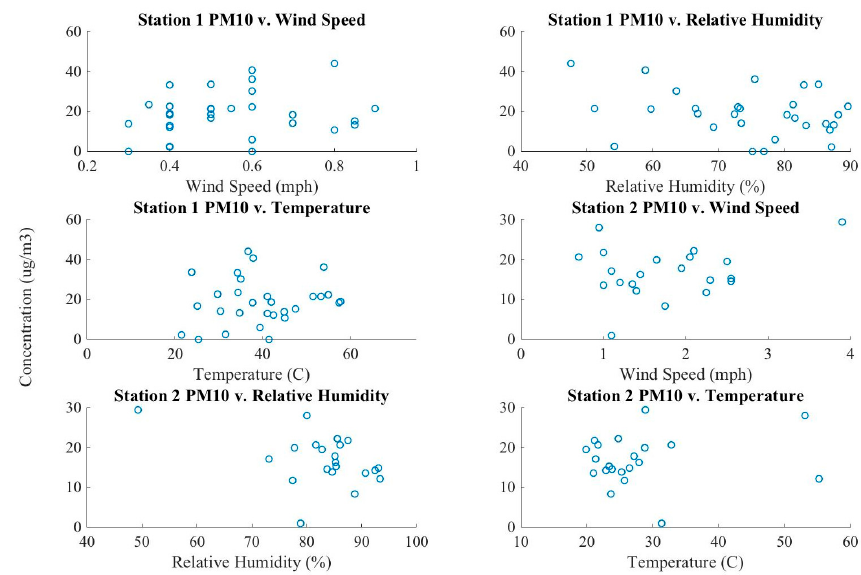
Figure 4. Comparing concentrations of PM 2.5 with meteorological variables for both Station 1 and Stations 2 and 3, denoted by Station 2 in this figure.